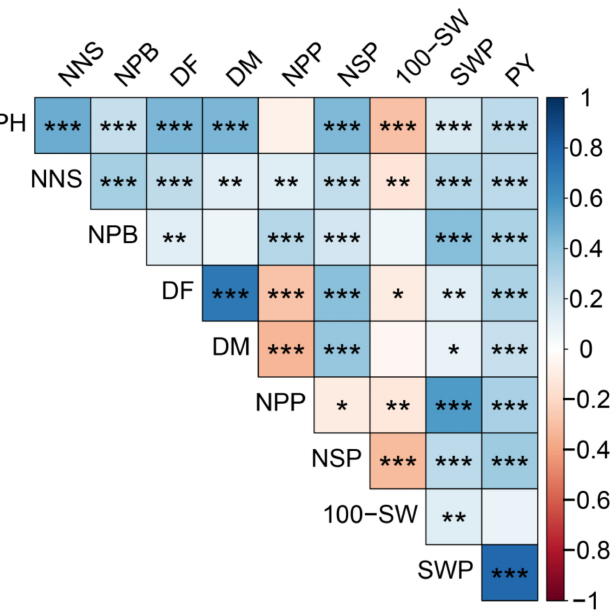
Figure 3. Spearman’s correlation matrix of 10 traits of 475 accessions. In the correlation matrices *, **, *** indicate significance at p < 0.05, p < 0.01 and p < 0.001, respectively. PH, plant height (cm);